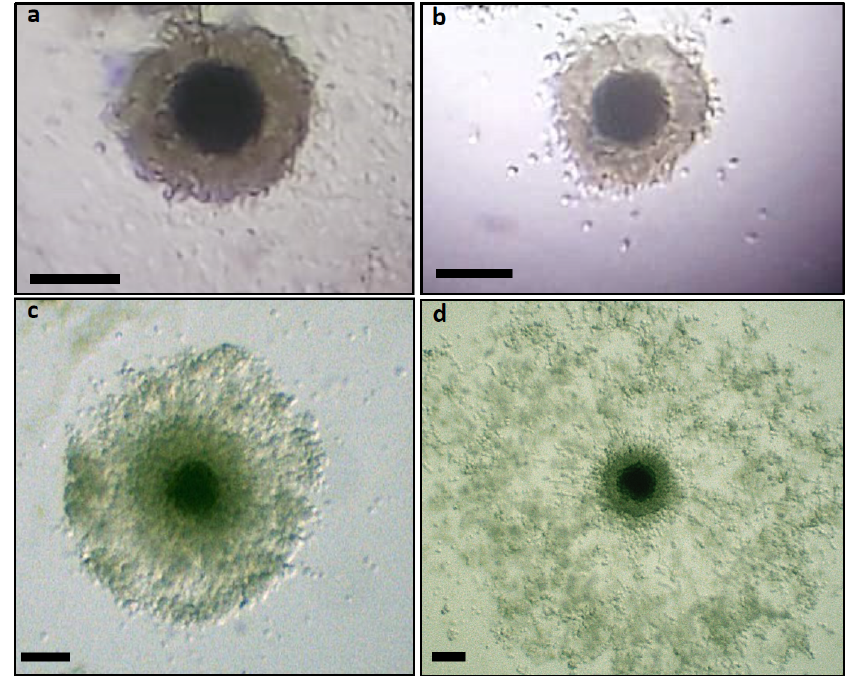
Figure 2. Canine cumulus–oocyte complexes (COCs) after 72 h of in vitro maturation. (a,b) COCs without cumulus cell expansion; (c,d) COCs with different grades of cumulus cell expansion (bar: 100 m).